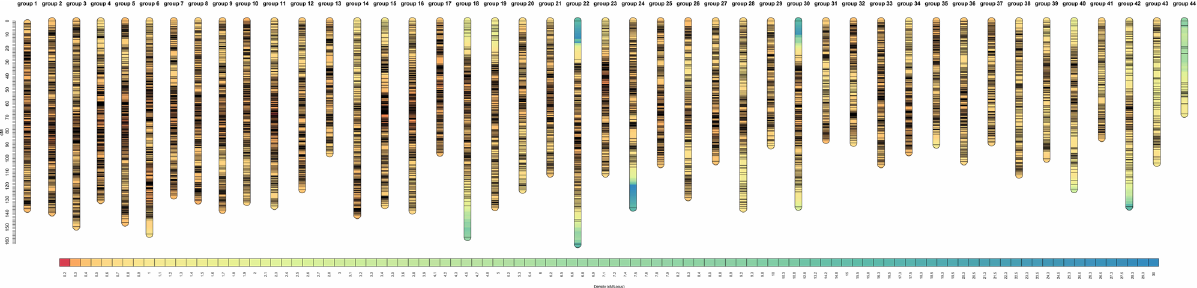
Figure 2. The high-resolution consensus map of F. chinensis which contain 12,884 markers in 44 linkage